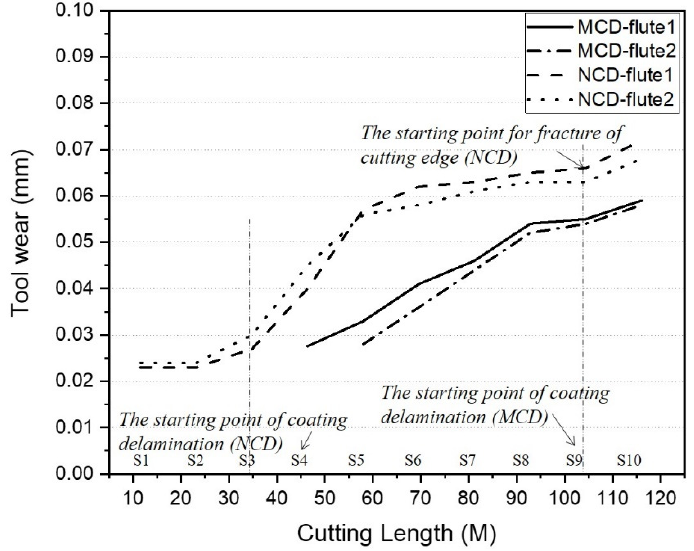
Figure 12. Comparison of tool wear according to cutting length of MCD and NCD-coated tools. Wear according to the cutting length of the two cutting edges for the